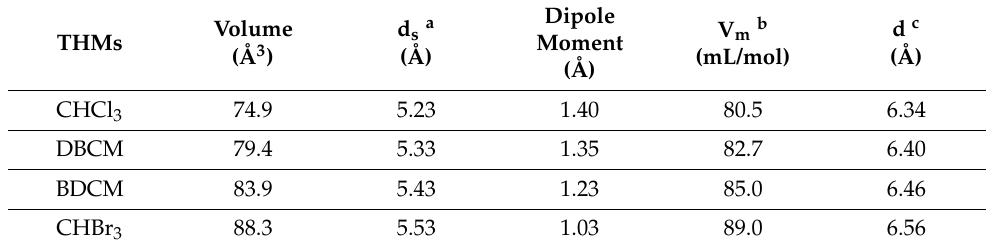
Table 5. Selected structural and physical properties of